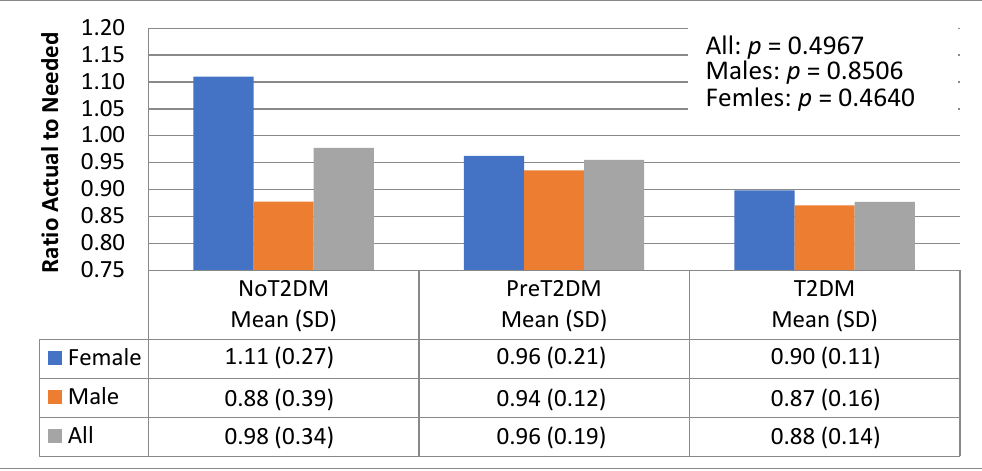
Figure 8. Actual to needed kilocalories from carbohydrates by diabetes status and gender.